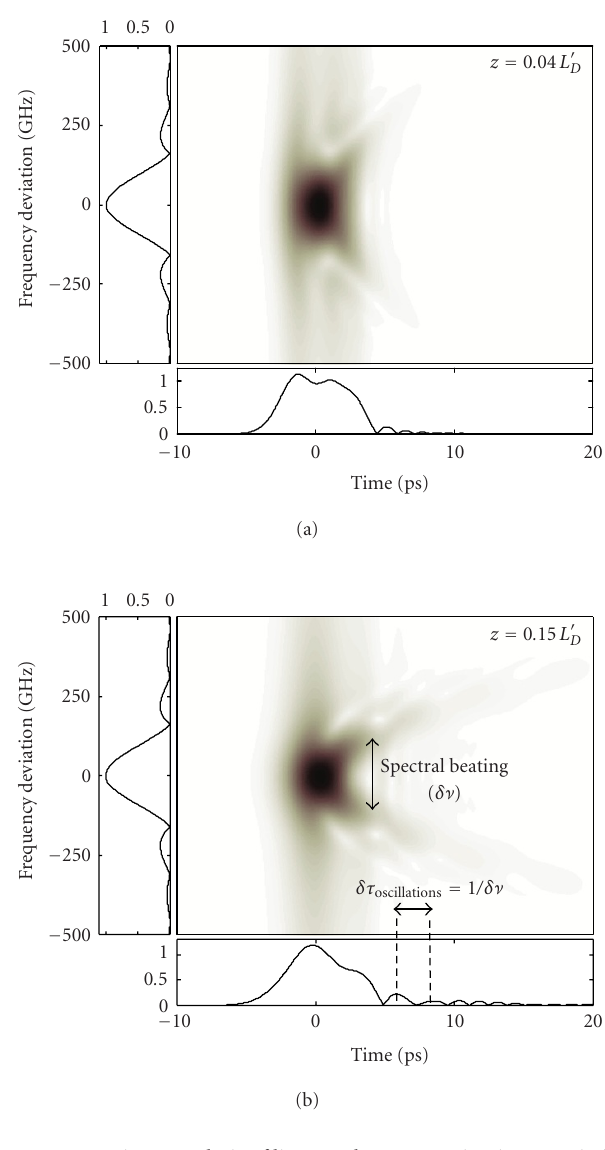
Figure 3: Wigner analysis of linear pulse propagation in an optical fiber (second-order